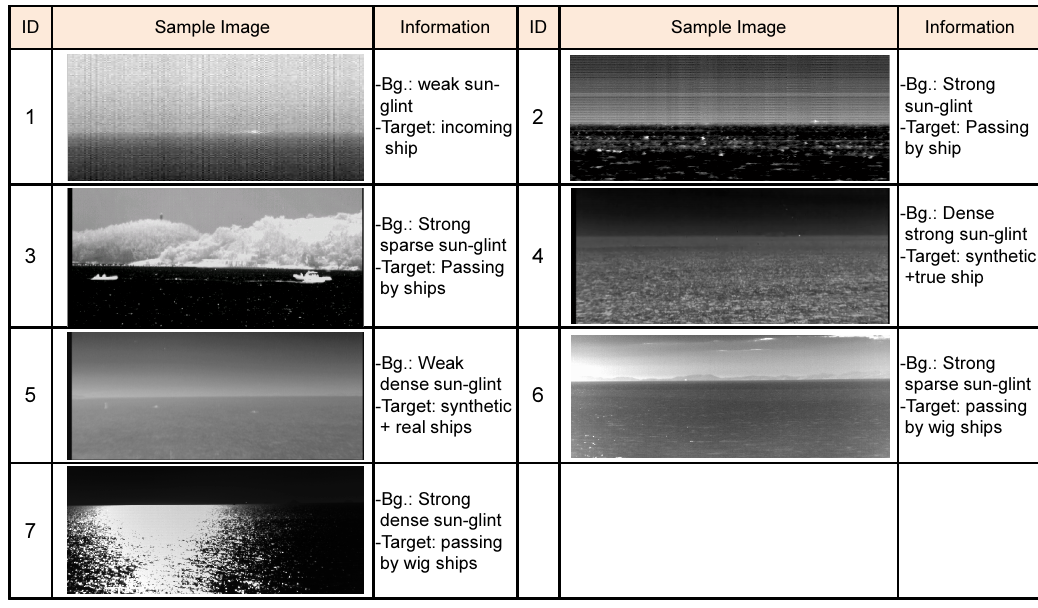
Figure 27. Composition of the test database.